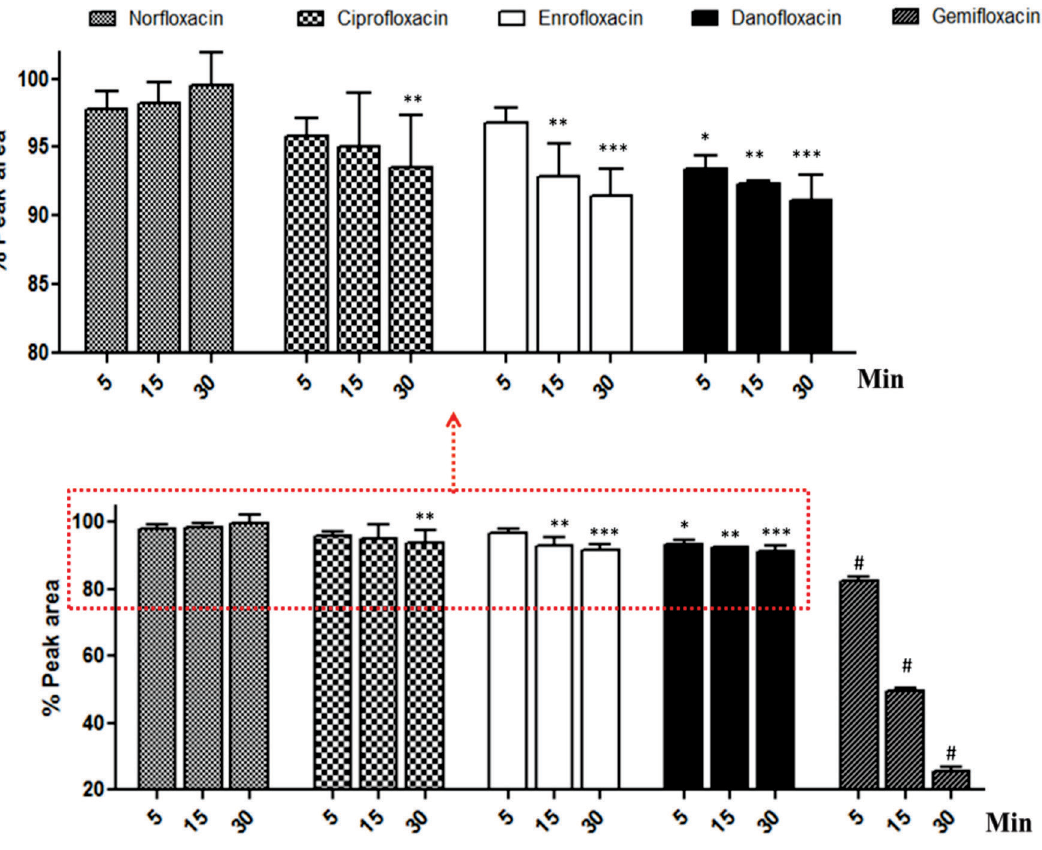
FIGURE 2 – Results of degradation of fluoroquinolones after UVC radiation under photolytic conditions (A) and expanded graphic to 100-75% peak axis area (B). Media and standard deviation are expressed in percentage. * means statistical difference p <0.05 compared to norfloxacin; ** means statistical difference p<0.01 to norfloxacin; *** means statistical difference p<0.001 to norfloxacin; # means statistical difference p <0.001 between gemifloxacin compared to other